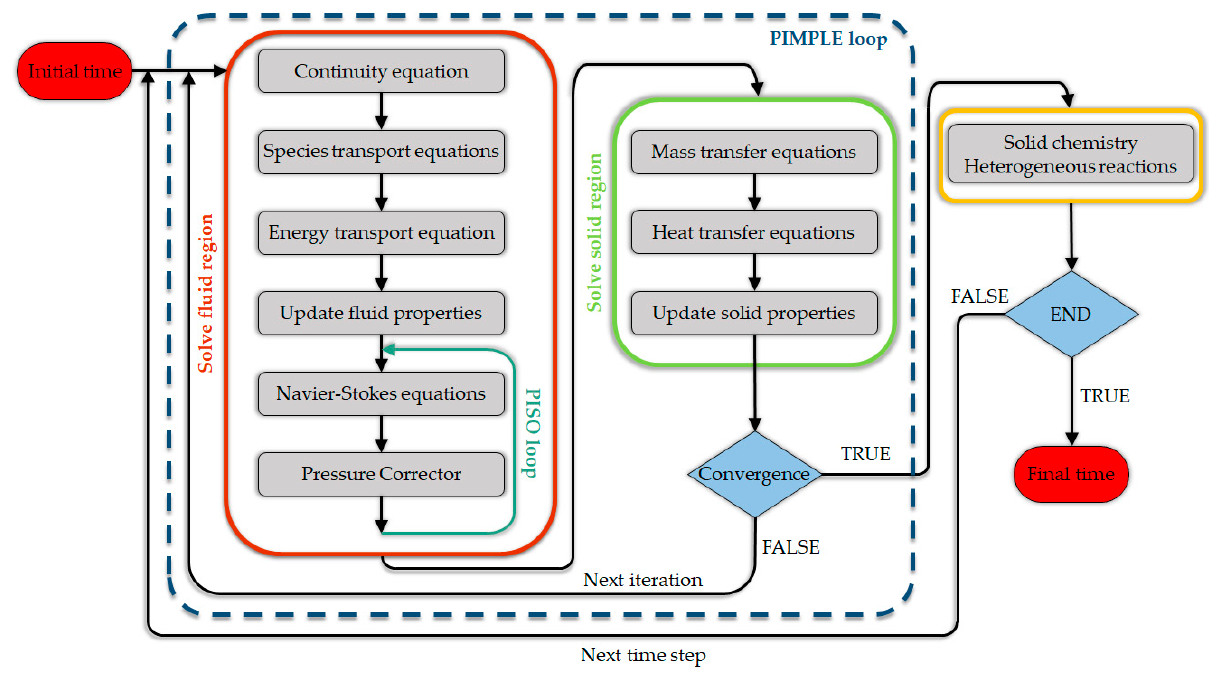
Figure 16. Multi-region catalyticFoam solver algorithm (Redrawn from Ref. [418]). Reprinted from Chemical Engineering Journal, Vol. 283, Tiziano Maffei, Giancarlo Gentile, Stefano Rebugh- ini, Mauro Bracconi, Filippo Manelli, Stefan Lipp, Alberto Cuoci, Matteo Maestri, A multi-region operator-splitting CFD approach for coupling microkinetic modeling with internal porous trans- port in heterogeneous catalytic reactors, Pages No. 1392–1404, Copyright (2015), with permission from